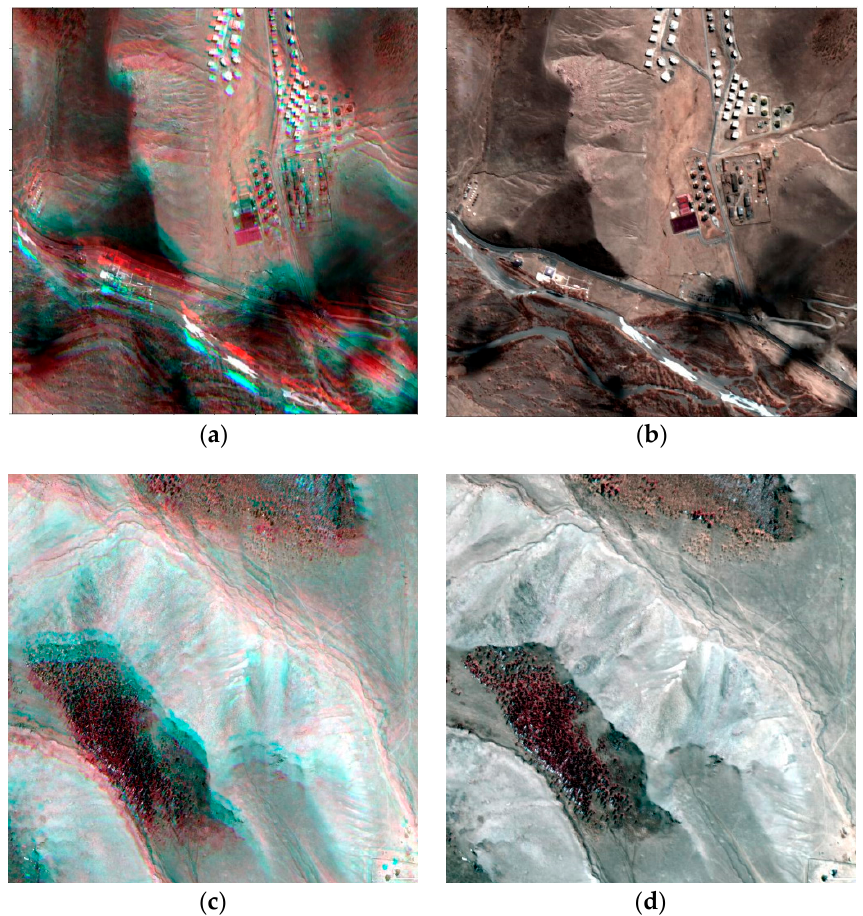
Figure 12. Examples of pan-sharpened images in false color ( a , c ) before and ( b , d ) after applying image co-registration.